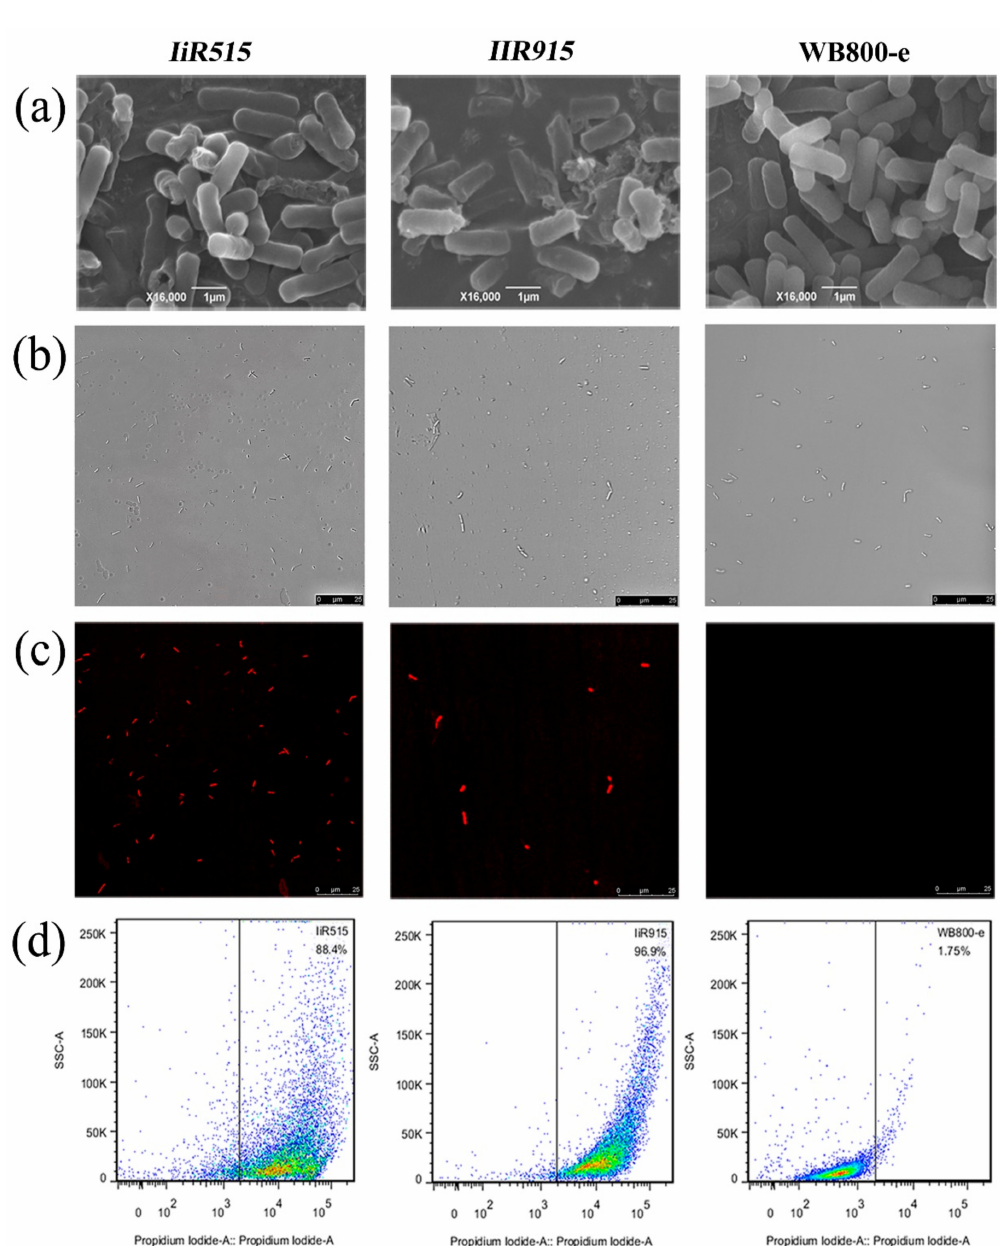
Figure 2. Cell membrane disruptions of transformed B. subtilis cells. Bacillus pellets were fixed with glutaraldehyde after washing with PBS bu ff er (phosphate bu ff er saline). Finally, the samples were lyophilized and then gold coated. ( a ) Cellular disruption of IiR515 , IiR915 , and WB800-e (empty vector-transformed B. subtilis WB800) under the scanning electron microscope. Test bacteria were washed and resuspended in PBS bu ff er at 1 × 10 9 CFU / mL and stained with PI (40 mg / mL). Confocal images under ( b ) ordinary light and ( c ) fluorescence. ( d ) Percentages of fluorescent events (relative value of PI staining) in gate shown in the region on the right. The x -axis shows the relative fluorescence intensity and the y -axis shows the side scatter